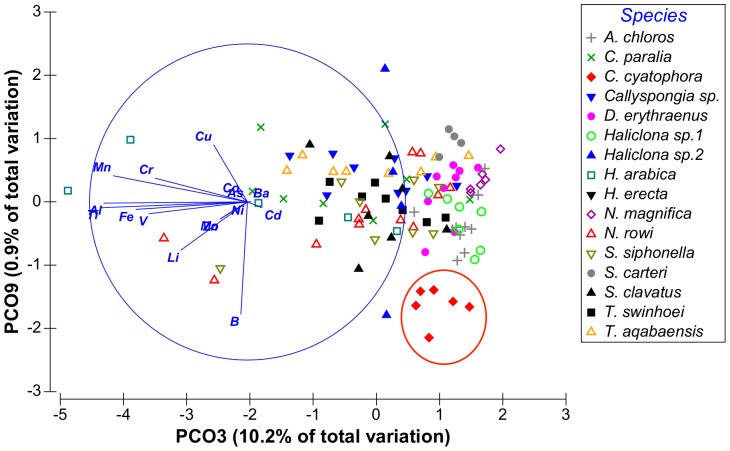
Distribution of sponge samples along PCOI vectors 3 and 9.Species of interest is circled in red.